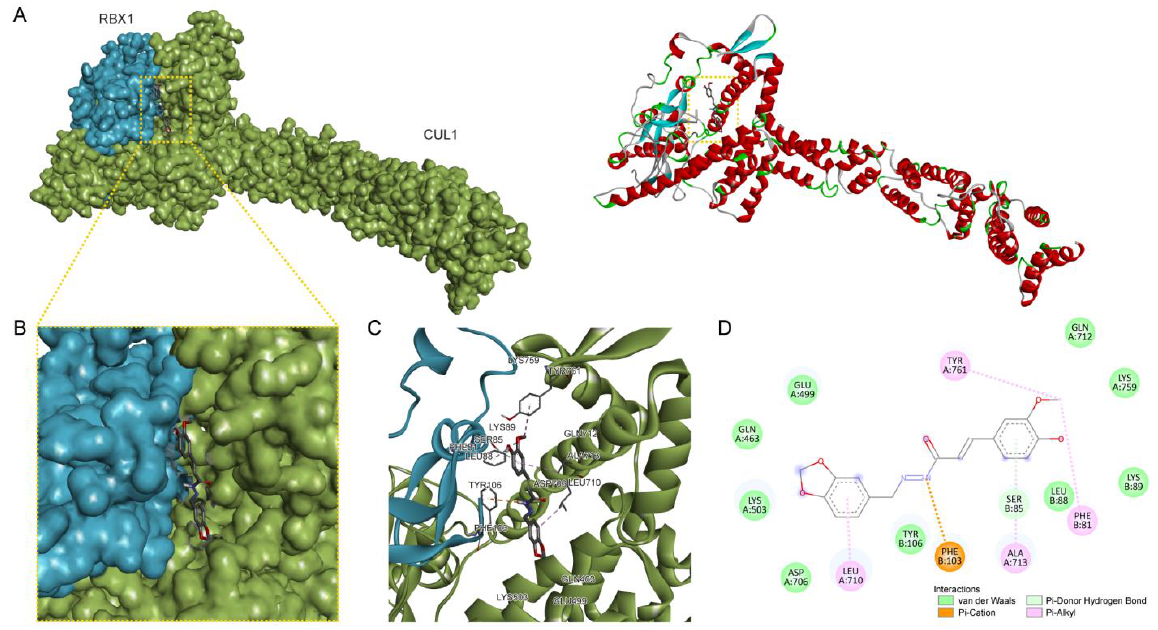
Figure 7. Molecular docking of 3a into the CUL1-RBX1 complex. ( A ) Overall view of CUL1-RBX1 complex bound with 3a , shown in the yellow dashed square inside the ligand surface (left) and inside the secondary structure (right). ( B ) Close-up view of interaction between 3a and the CUL1-RBX1 receptor surface. ( C , D ) Detailed interactions of 3a with the receptor amino acids shown in three ( C ) and two dimensions ( D ).